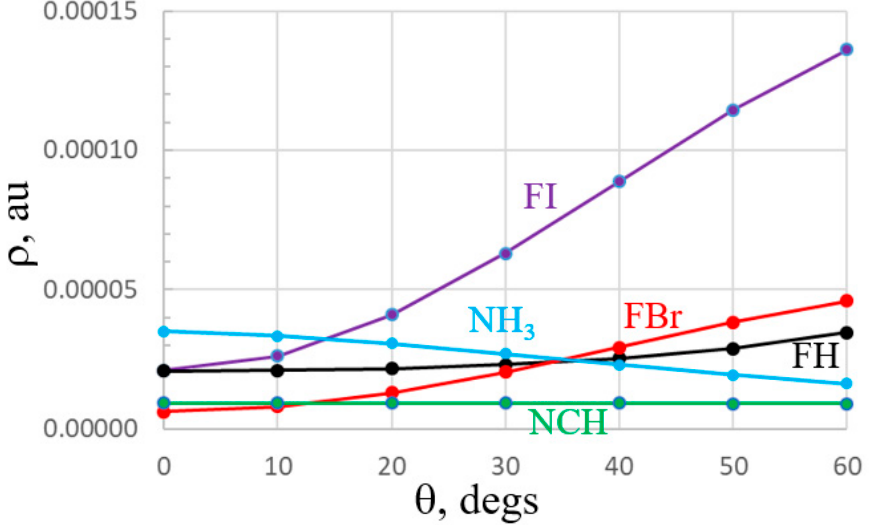
Figure 8. Total electron densities of indicated monomers, plotted against deviation angle θ from FX axis for acids, NCH axis for NCH, and C 3 symmetry axis of NH 3 . Potentials were evaluated along a circle centered about the X or N atom, with a radius of 3 Å for all except 2 Å for FH.